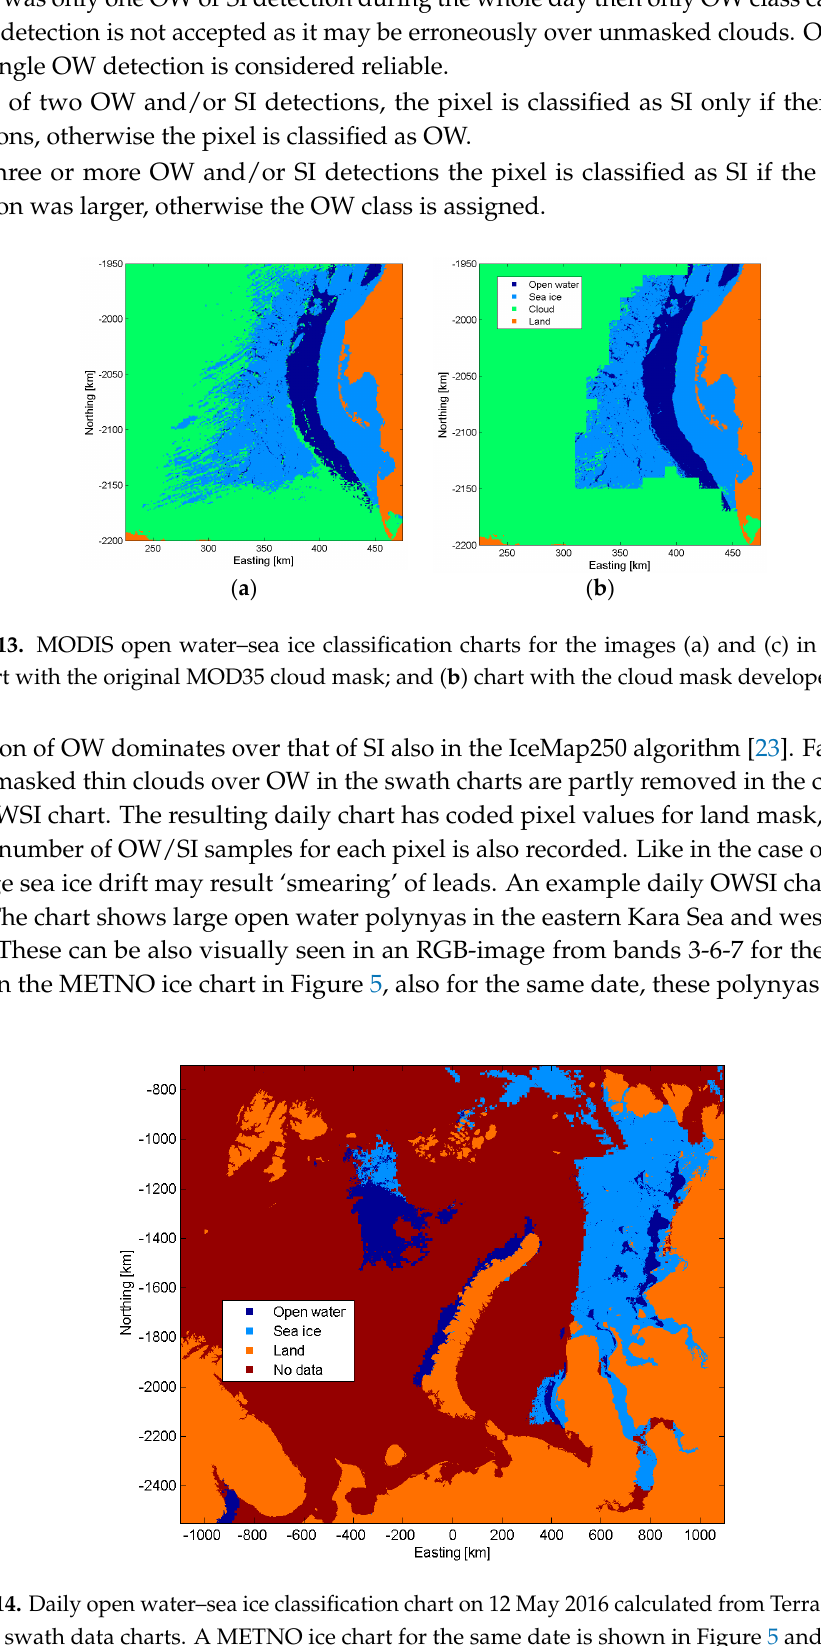
Figure 12. ( a ) MODIS RGB 2-1-1 image with overlaid cloud mask from the MOD35 product (‘cloudy’ of unobstructed FOV confidence flag); ( b ) cloud mask after clear-sky restoration over open water using the band 1 TOA reflectance—amount of false cloud detections over the lead has decreased; ( c ) the final cloud mask in 10 km block size—blocks with less than 25% cloud fraction have cloudy 250 m pixels; and, ( d ) band 1 reflectance image which by visual analysis suggests that there is thin ice in the left edge of the lead, not clouds (see ( a )). The MODIS data was acquired on 12 May 2016 at 07:55